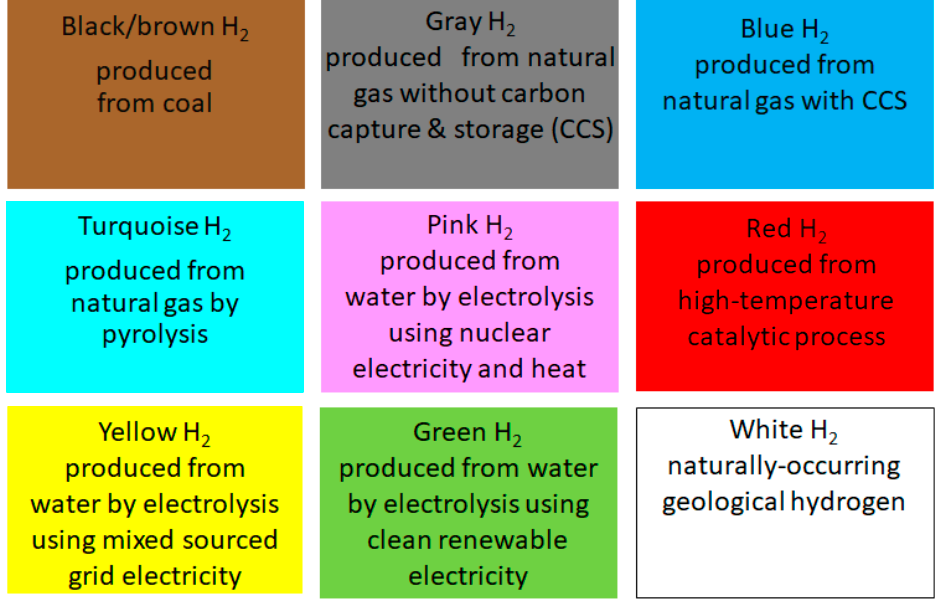
Figure 3. The spectrum of H 2 production processes.